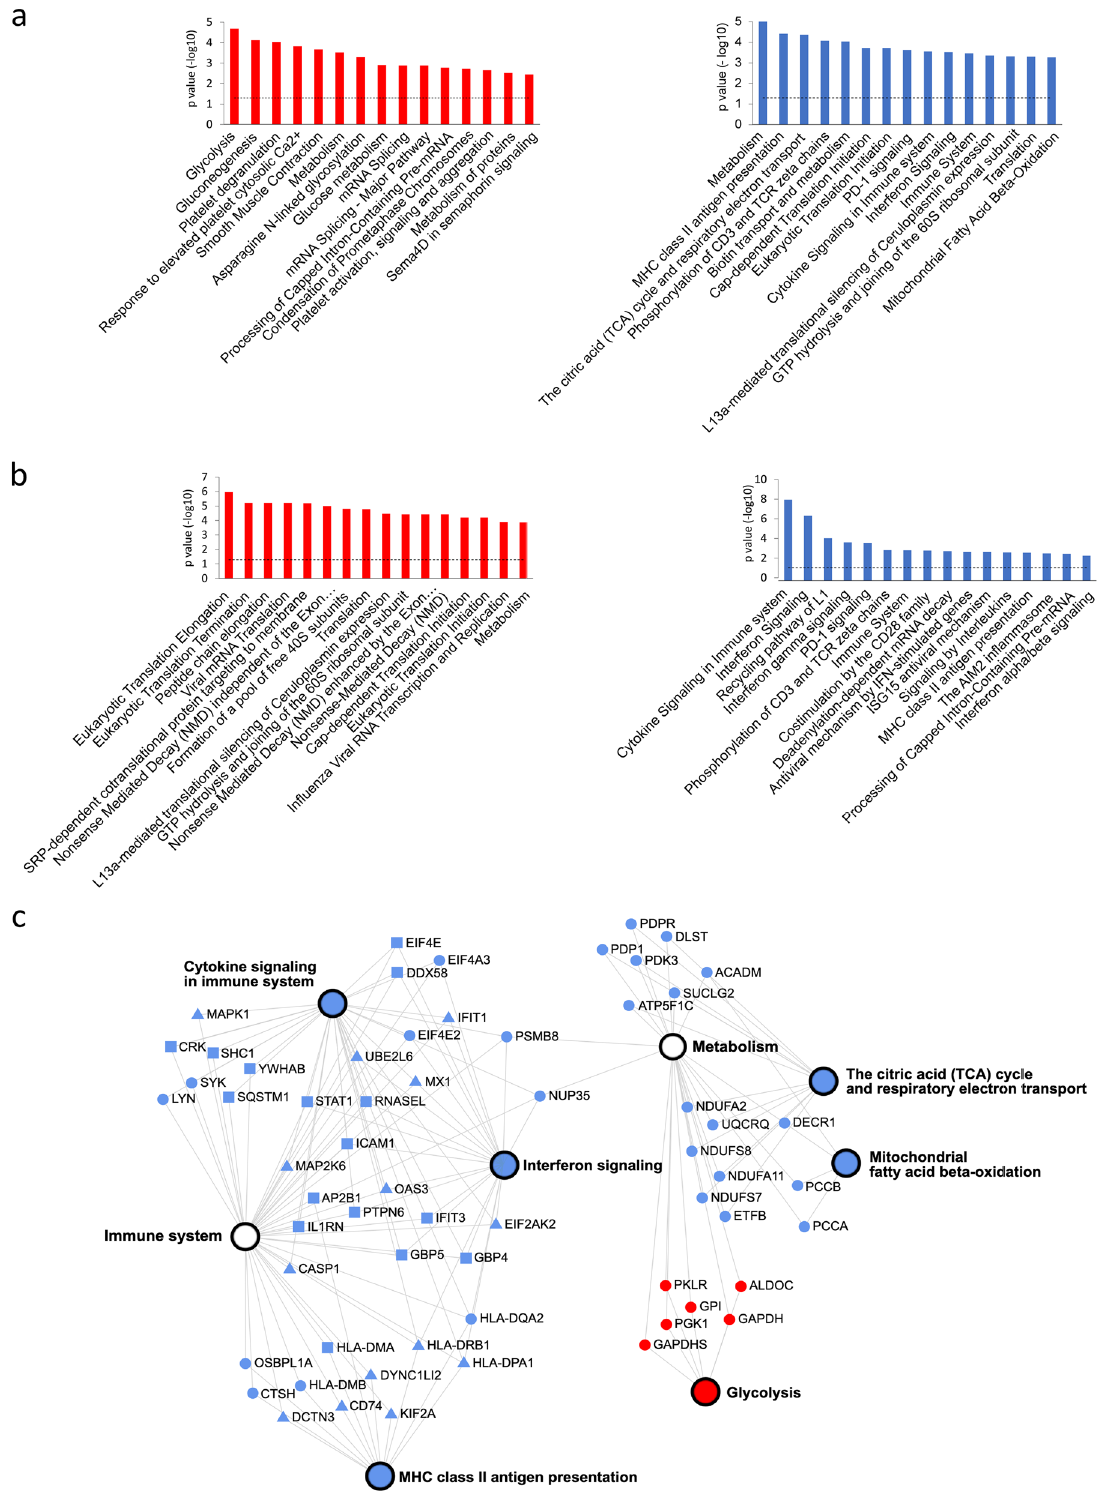
Figure 2. Functional analysis of the sepsis monocyte proteome. Enriched Reactome pathways among the differentially expressed proteins in groups ( a ) Sepsis, compared to Control and; ( b ) Sepsis, compared to Recovery. The y-axis represents the − log10 of the p value for the association between the pathways and the set of proteins up (red bars) or down (blue bars)-regulated. Significance (dotted lines) was defined as p ≥ 0.05 (Benjamini and Hochberg); ( c ) A network of pathways selected from ( a , b ). Nodes represent proteins up (red) or down (blue)-regulated in the comparisons between Sepsis and Control (circles), Sepsis end Recovery (squares), or both comparisons